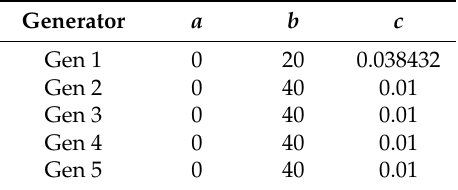
Table 2. Fuel cost parameters of diesel engines.